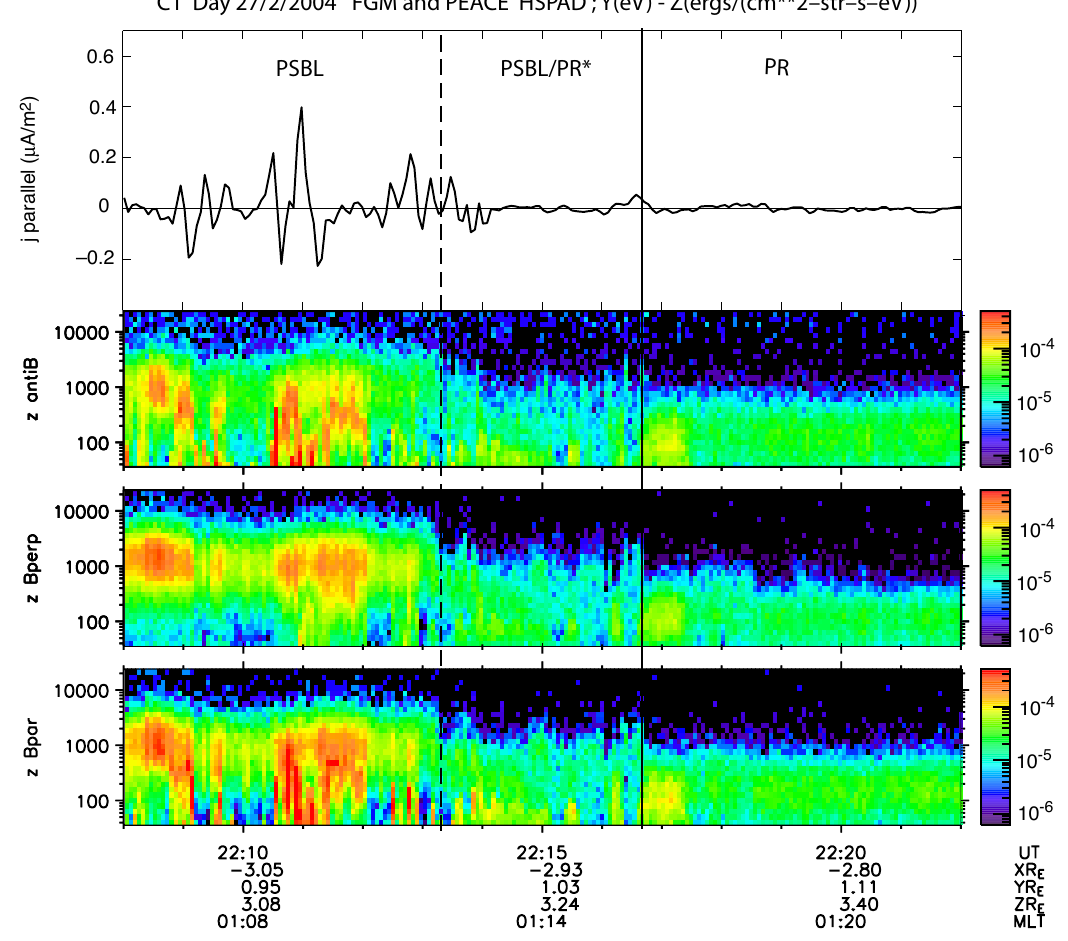
Fig. 10. Downward FAC for C1 (top panel) and PEACE data in the same format as Fig. 6 (bottom panels). Both satellites show upflowing (see the bottom panel for pitch-angle of low-energy ions) O + and H + ions within the PSBL region with energies of 50–500 eV. Hydrogen fluxes exceed 10 7 cm − 2 s − 1 while oxygen fluxes are somewhat smaller. This region of ion outflow is marked by filled dots in Fig. 5. One can see that this 4 ◦ cgmLat (6 ◦ cgmLat) wide region by C1 (C4) corresponds to the poleward part of the oval and the poleward part of the westward electrojet region up to the PCB. In Figs. 3 and 4 the ion outflow region is shown by triangles. Ion outflow coincides with a region of enhanced electron temperature rather than increased ion tem- perature in the ionospheric F region. Elevated electron tem- perature increases the scale height of ions and the ambipolar diffusion coefficient. For example, the measured ion tem- perature of 2500 K (at an altitude 400 km) corresponds to a thermal energy of 0.3 eV for ions. If the observed ions are of ionospheric origin, they must be energized between the ionosphere and the Cluster altitude (3.4 R E ). One possibility is energization by waves.